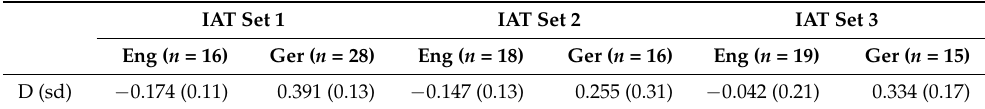
Table 10. Descriptive statistics IAT. D-scores (D) according to the IAT set and the participants (English- or